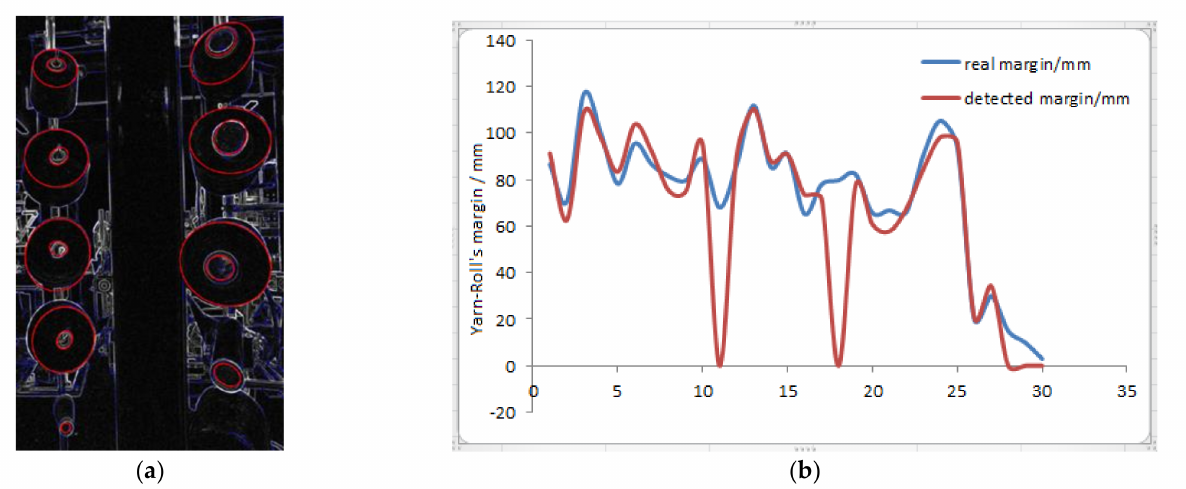
Figure 11. The detection results ( a ) The thread rolls and bobbins are detected and drawn in image. ( b ) The comparison between the real thread roll’s margin and the calculated margin. Red line is the margin detected from 30 different thread rolls, blue line is its real margin.